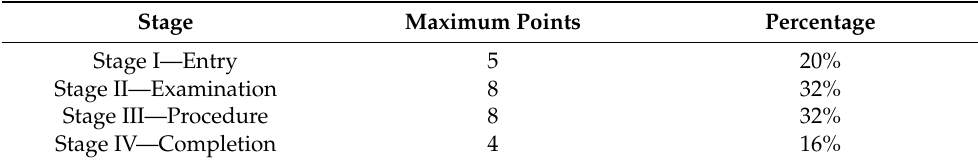
Table 1. Distribution of VACS parameter weights in the four